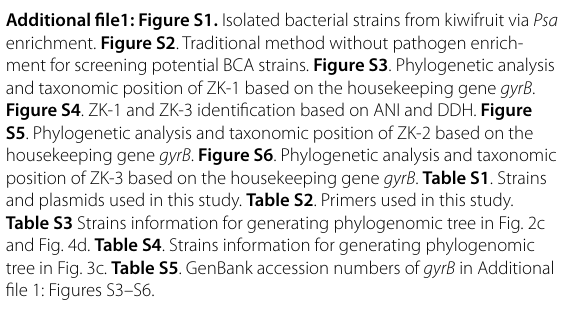
and Fig. 4d. Table S4 . Strains information for generating phylogenomic tree in Fig. 3c. Table S5 . GenBank accession numbers of gyrB in